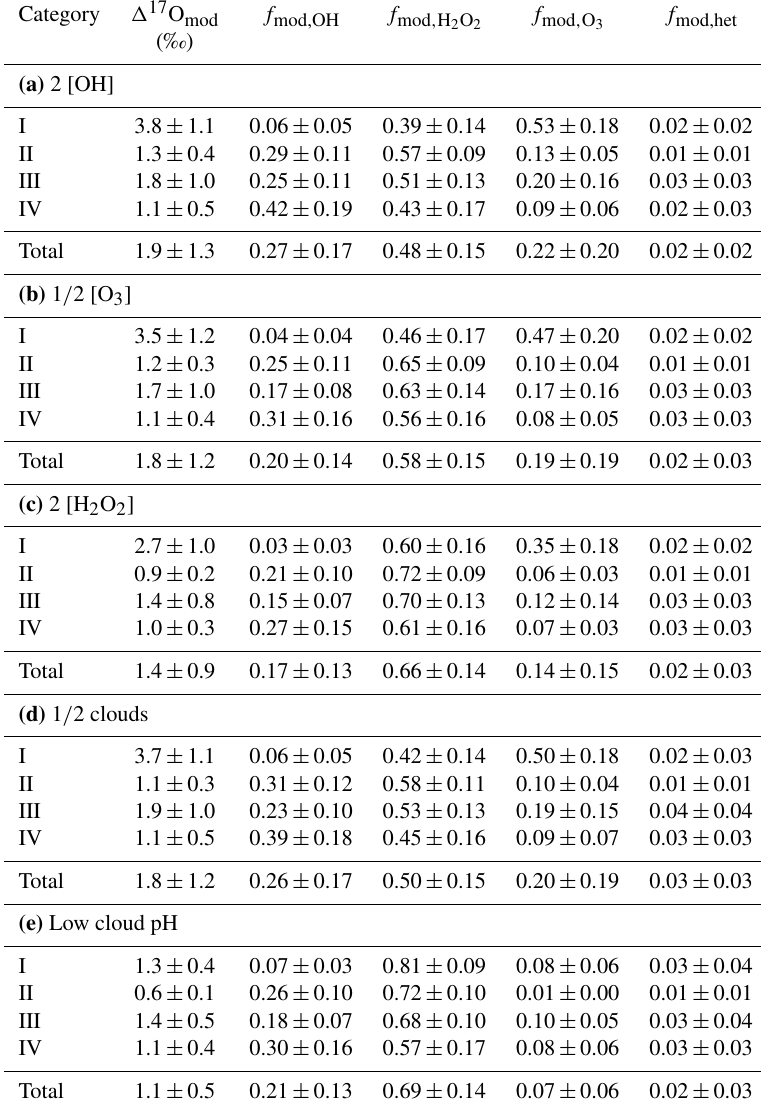
) , f mod , O Table 3. (cid:49) 17 O mod ( nssSO 2 − , f mod , H and f mod,OH obtained from five sensitivity studies: (a) double OH concentration, (b) half 4 3 2 O 2 O 3 concentration, (c) double H 2 O 2 concentration, (d) half clouds and (e) low cloud pH.